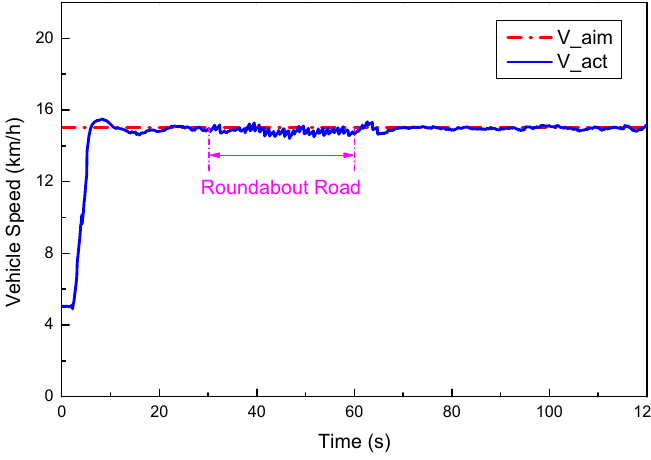
Figure 16. Longitudinal velocity tracking on roundabout.